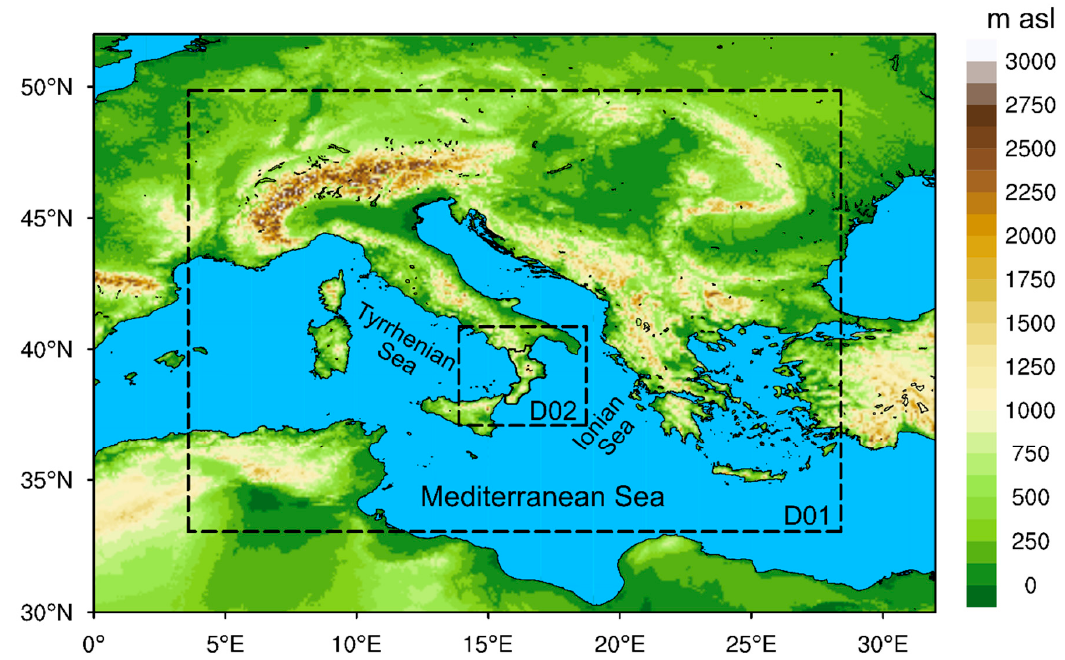
Figure 1. WRF computational domains (dashed lines). The outermost domain D01 is centered over the central Mediterranean Sea, and the innermost D02 is centered over the Calabria region, whose northern border is highlighted with a black bold line. Table 1. Main features of the simulations performed in this study.